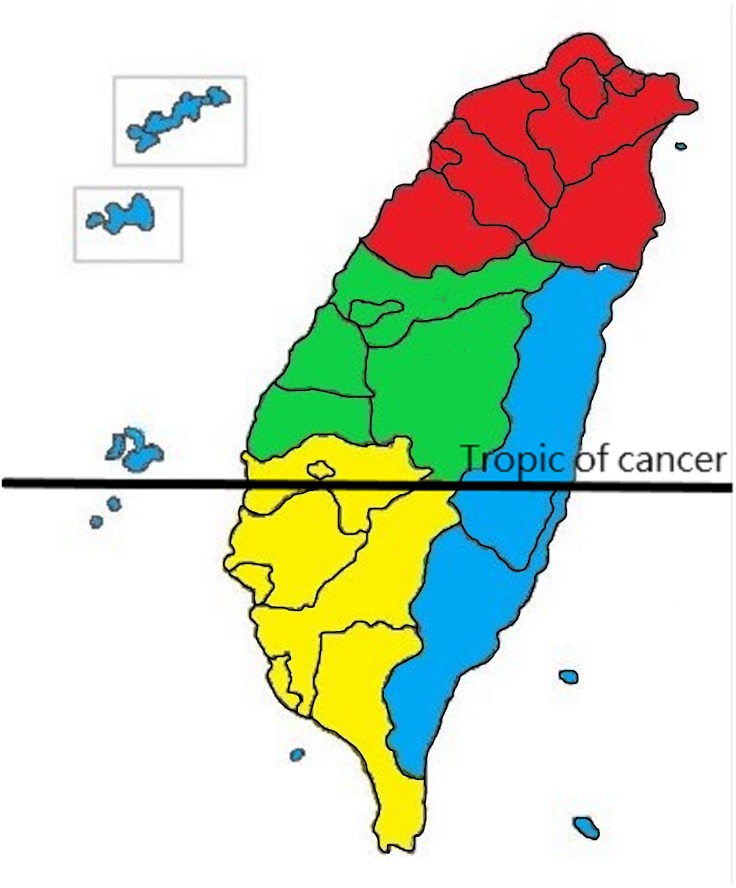
Definition of residential area in Taiwan.Red is designated for the northern area, green for the central, yellow for the southern, and blue for the eastern and offshore islands.